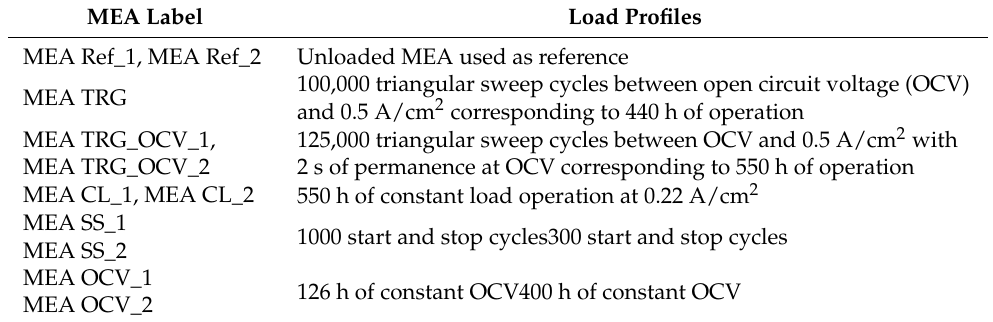
Table 1. Load profiles description of all membrane electrode assemblies (MEAs) (abbreviations: TRG: triangular sweep cycles, OCV: open circuit voltage, CL: constant load, SS: start and stop).